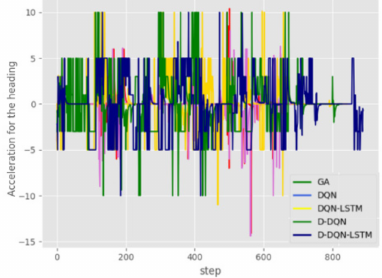
Figure 12. Heading angle curves of five algorithms in a static environment.